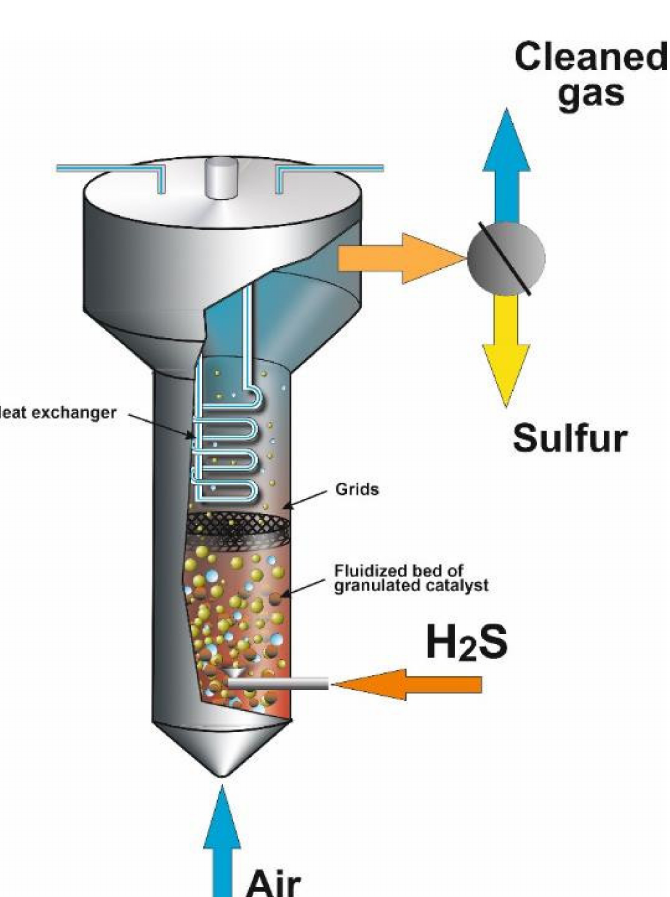
Figure 14. Direct catalytic oxidation in a reactor with a fluidized catalyst bed. Basic engineering